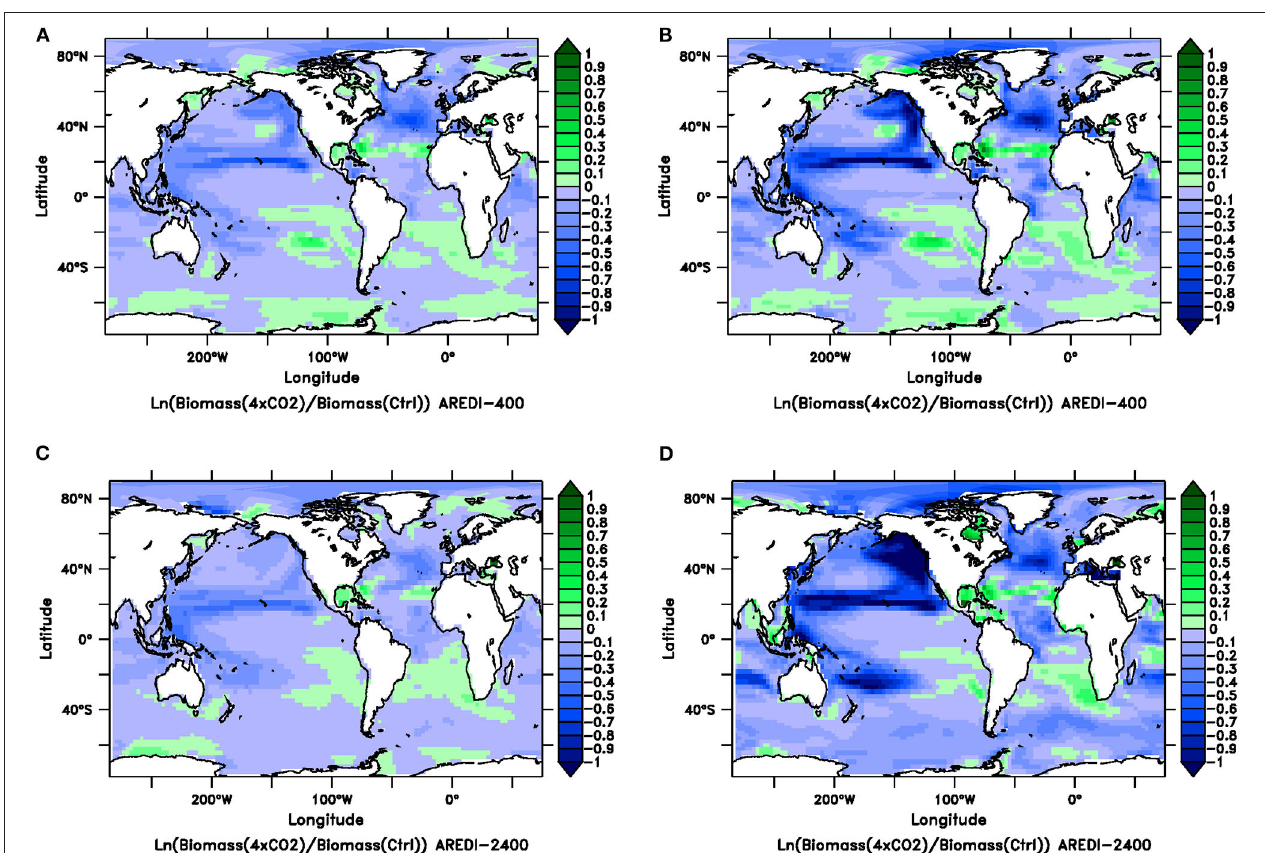
FIGURE 8 | Relative changes (natural log of the quotient of the value in century-long climatology of the 4xCO 2 run over the value in a century-long climatology of the Control) in total phytoplankton biomass (left column) and large phytoplankton biomass (right column) for the AREDI-400 case (top row) and AREDI-2400 case (bottom row). (A) Relative change in total phytoplankton biomass for the AREDI-400 case, (B) Relative change in large phytoplankton biomass for the AREDI-400 case, (C) relative change in total phytoplankton biomass for the AREDI-2400 case, and (D) relative change in large phytoplankton biomass for the AREDI-2400 case. Small values are effectively fractional changes. The color bar denotes the size of the logarithmic change, so that blue denotes lower biomass; green denotes higher